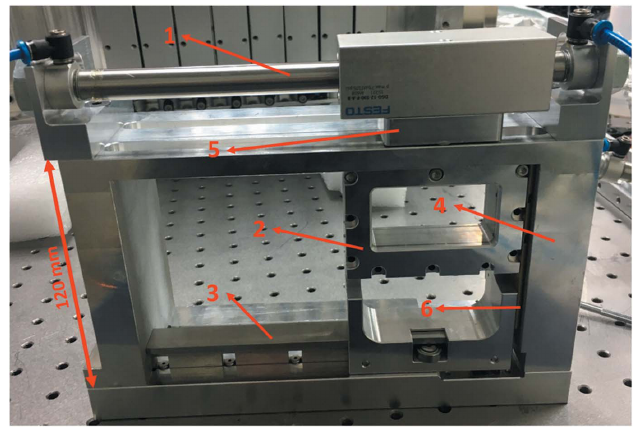
Figure 7 Experimental model of the attenuator: (1) pneumatic actuator, (2)